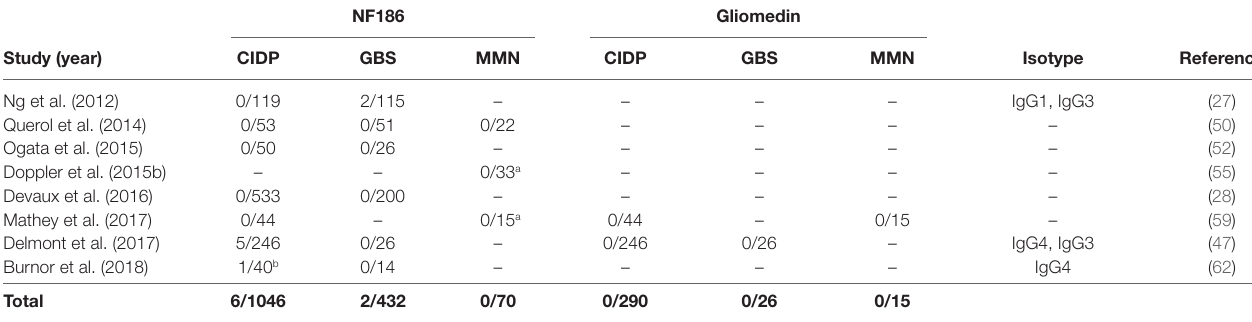
TABLe 2 | Studies that tested autoantibodies against neurofascin 186 (NF186) and gliomedin by using native human